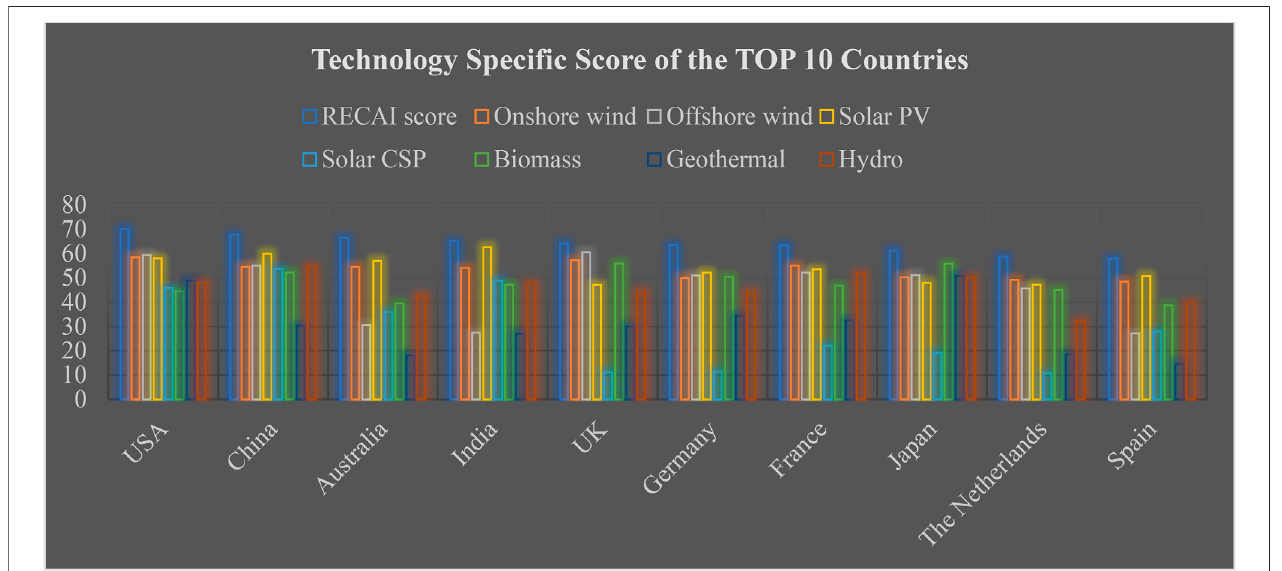
FIGURE 2 | Comparison of technology-speci fi c score of top 10